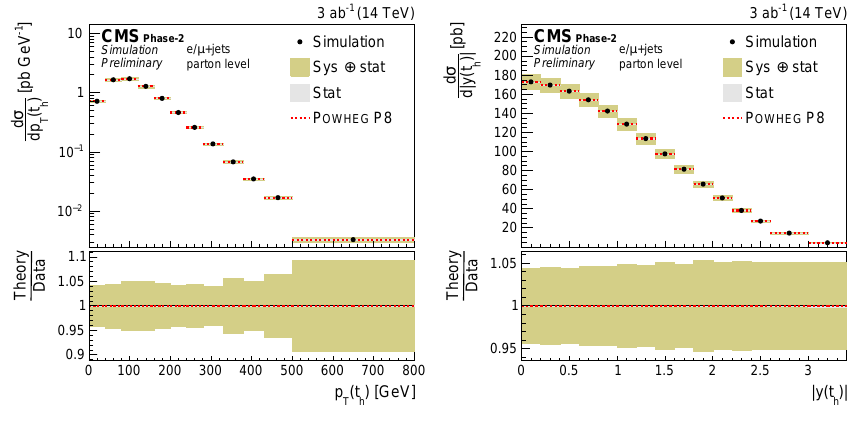
Figure 3: Projected t ¯ t differential cross sections as a function of the top quark trans- verse momentum (left) and rapidity (right) [ 9 ] .